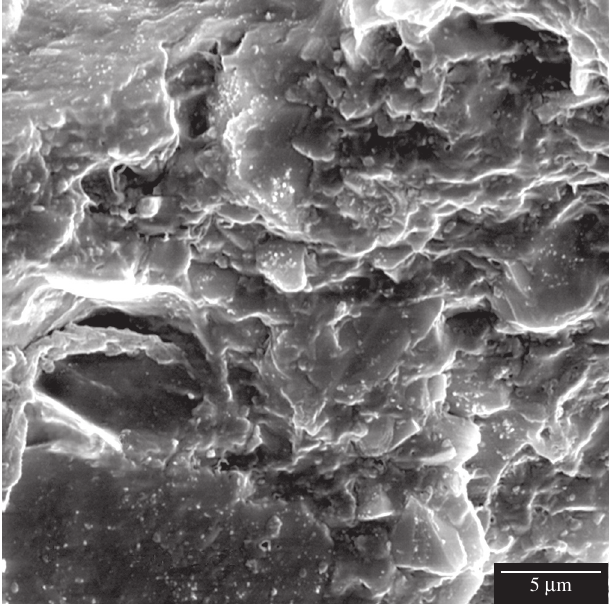
Co Fe O hexaferrite: 3 2 24 41